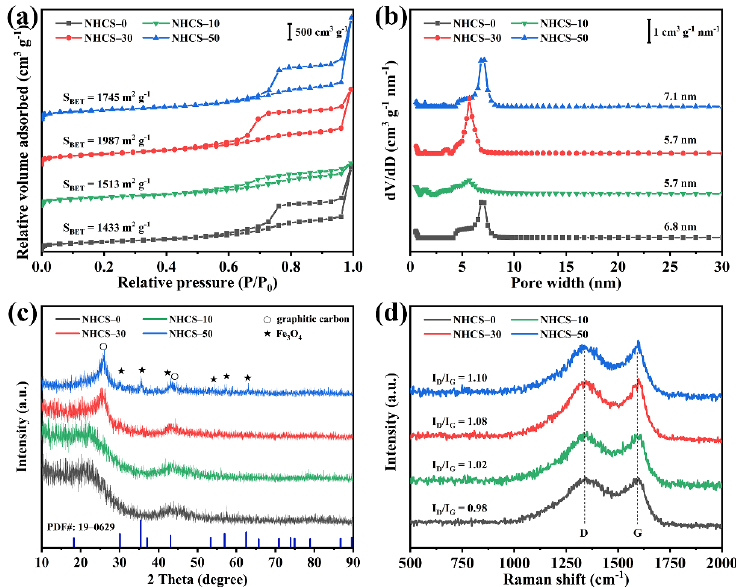
Figure 3. ( a ) Nitrogen adsorption-desorption isotherms and ( b ) the corresponding DFT pore size distribution curves; ( c ) XRD patterns; ( d ) Raman spectra of NHCS- m